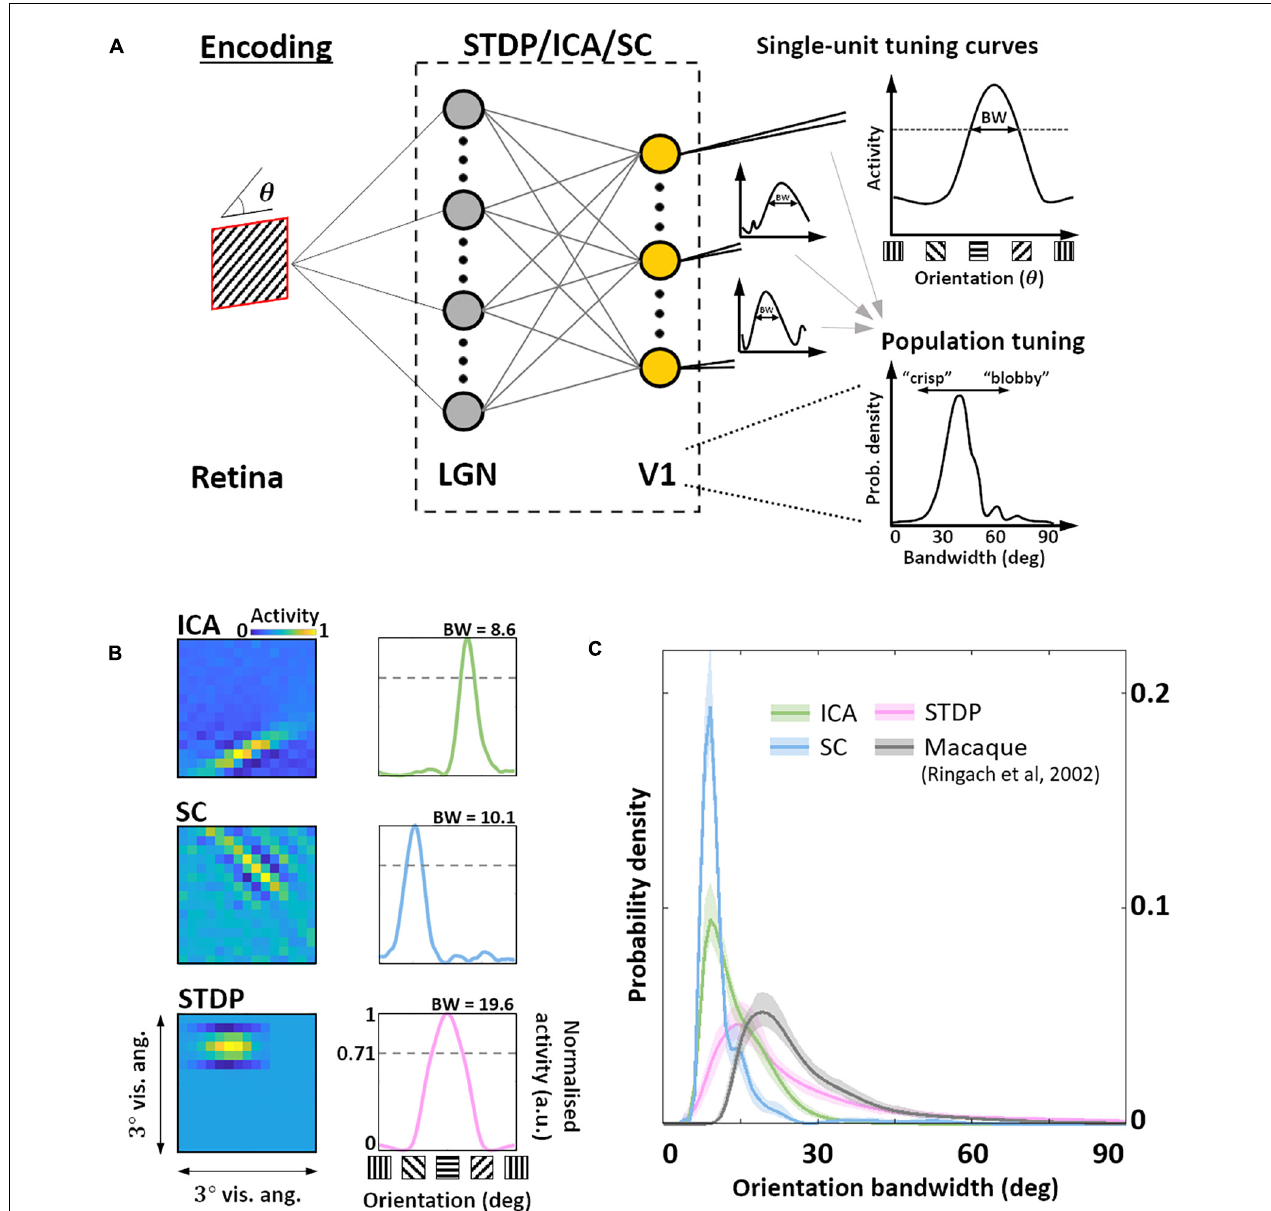
FIGURE 3 | Orientation encoding. (A) Orientation tuning. Sine-wave gratings with additive Gaussian noise were presented to the three models to obtain single-unit orientation tuning curves (OTCs). OTC peak identifies the preferred orientation of the unit, and OTC bandwidth (half width at 1 / selectivity around the peak. Low bandwidth values are indicative of sharply tuned units while high values signal broader, less specific tuning. (B) Single-unit tuning curves. RF (left) and the corresponding OTC (right) for representative units from ICA (top row, green), SC (second row, blue), and STDP (bottom row, pink). The bandwidth is shown above the OTC. (C) Population tuning. Estimated probability density of the OTC bandwidth for the three models (same colour code as panel B ), and data measured in macaque V1 (black) (Ringach et al., 2002) . Envelopes around solid lines show 95% confidence intervals estimated using a bootstrap procedure. All simulations shown here were performed at an input SNR of 0